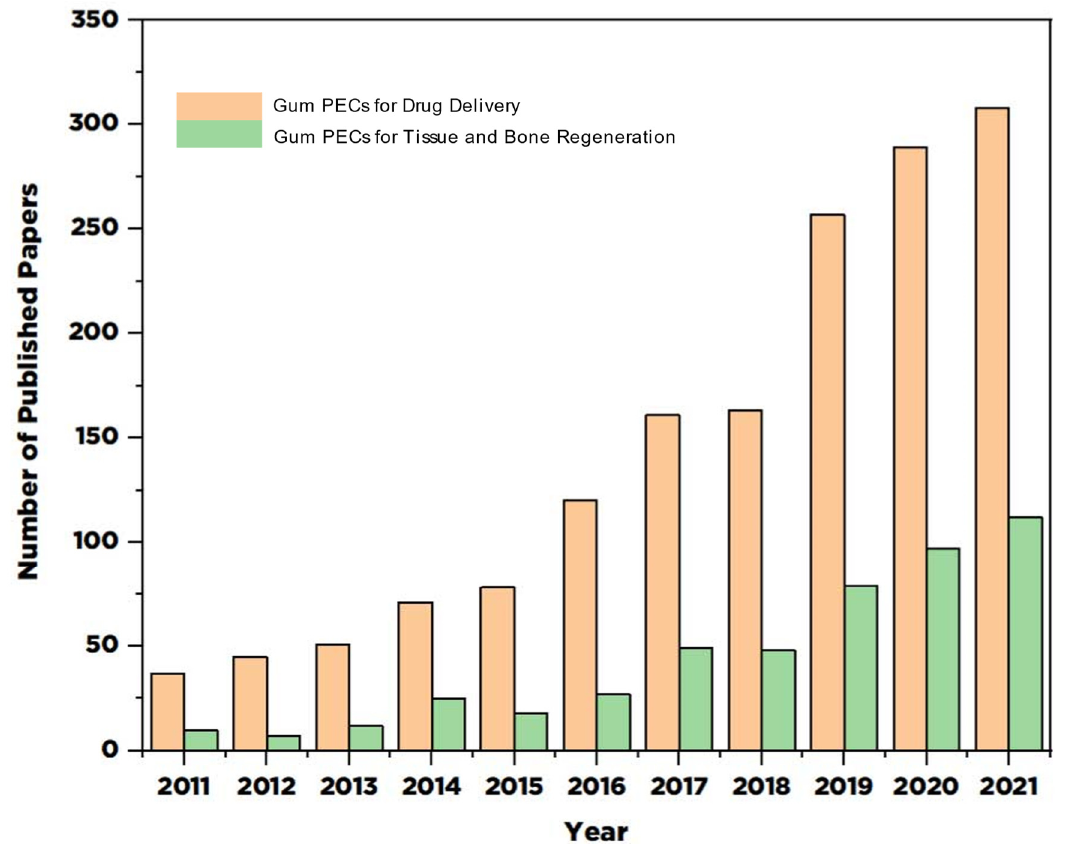
Figure 4. The number of publications in the field of gum-based PECs for drug delivery, tissue and bone regeneration indexed by Scopus from 2011 until recent (24 August 2021). Data analysis was evaluated on Scopus using the keywords: Gum Polyelectrolytes for “x” (x stated as drug delivery, tissue engineering and bone regeneration).